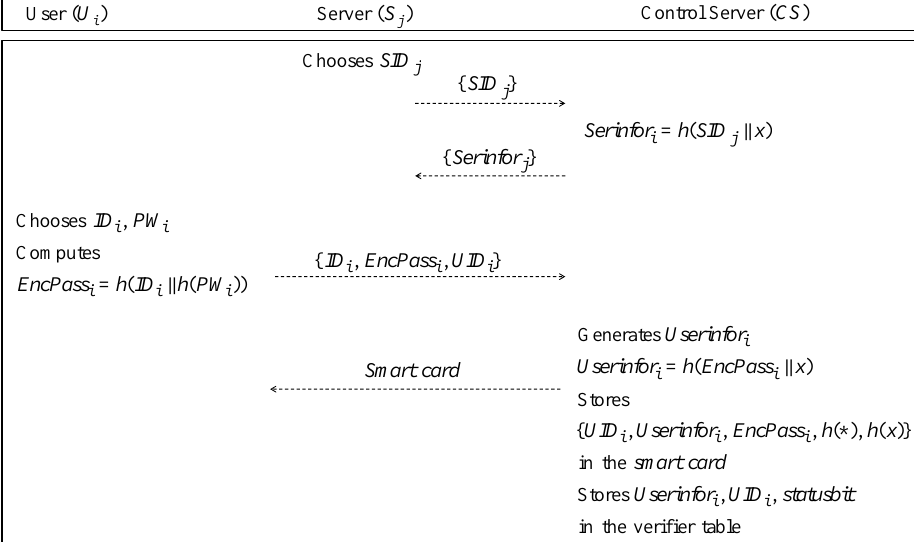
Figure 2. Registration phase of Bae et al.’s